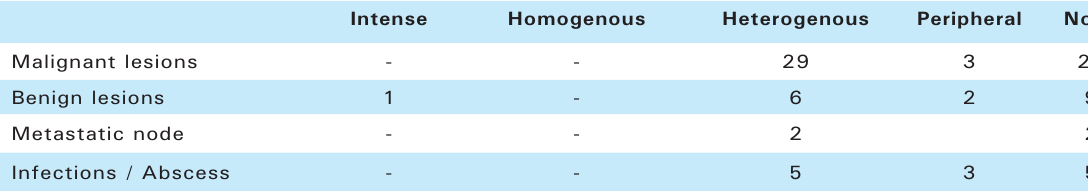
Table 2. Characteristics of lesion according to contrast enhancement patterns.